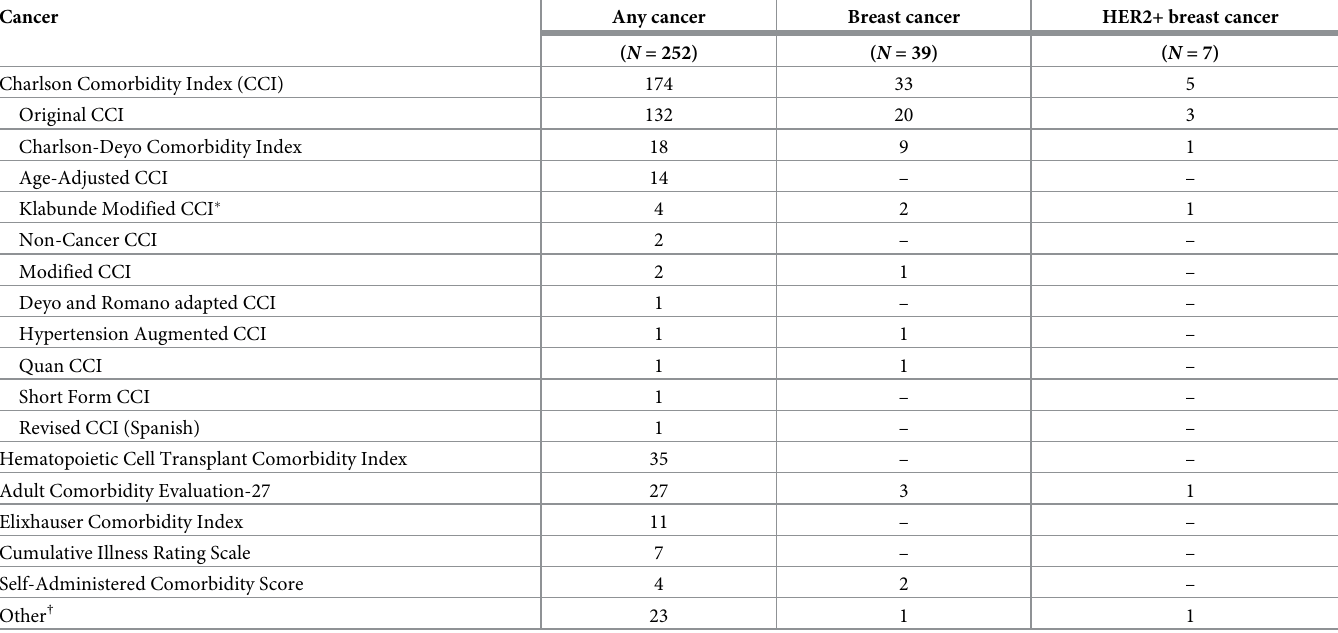
Table 2. Comorbidity indices used in the articles included in this